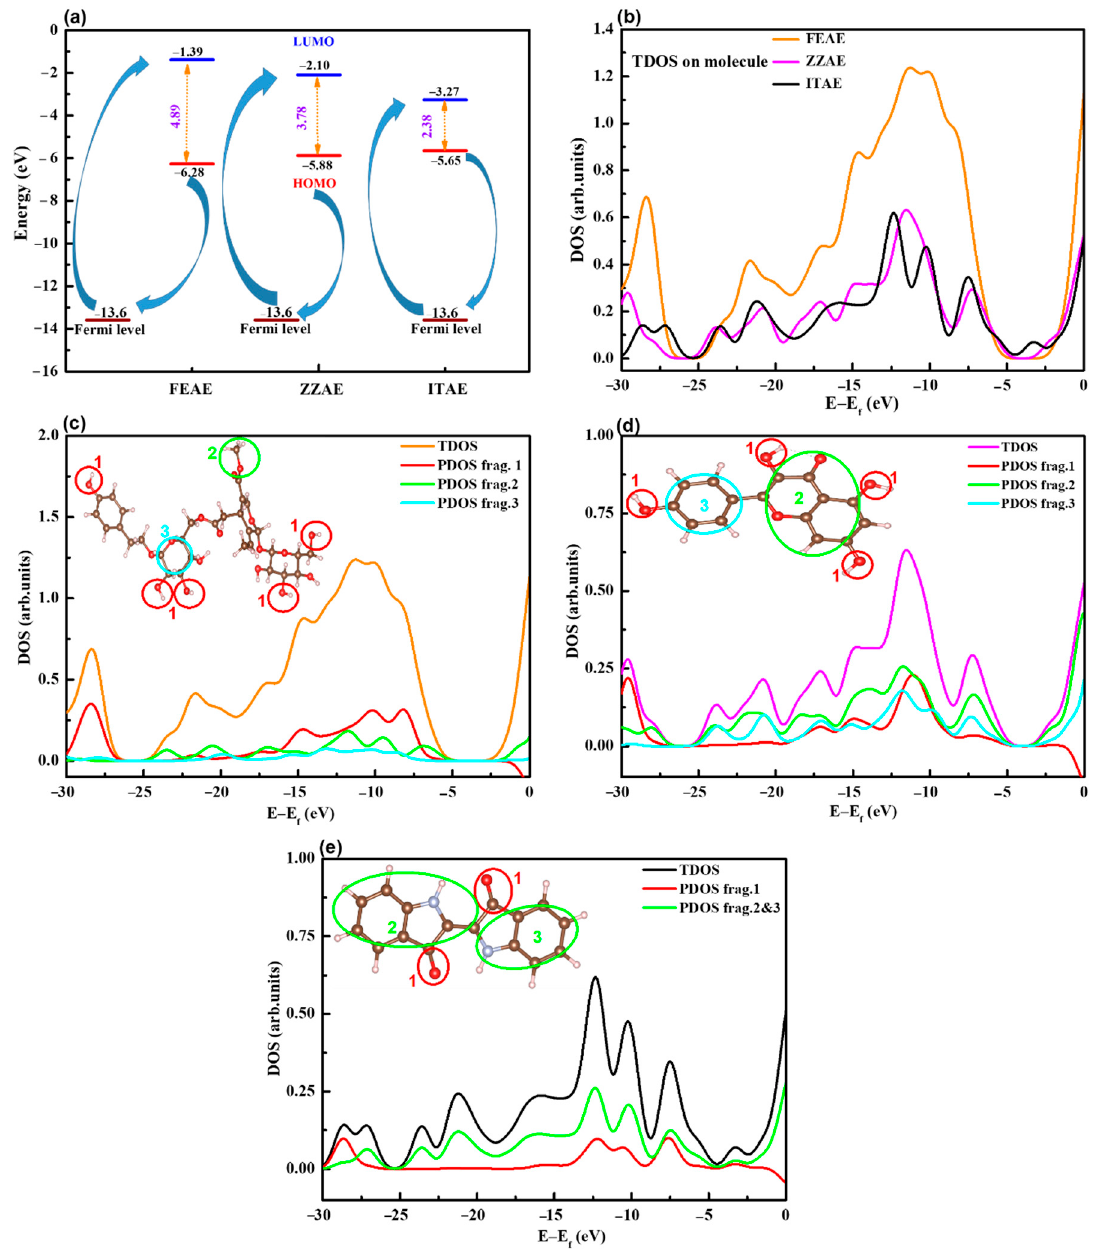
Figure 8. ( a ) HOMO and LUMO energetic positions and energy gap, ( b – e ) distribution of total and partial density of states (TDOS and PDOS) for natural products.